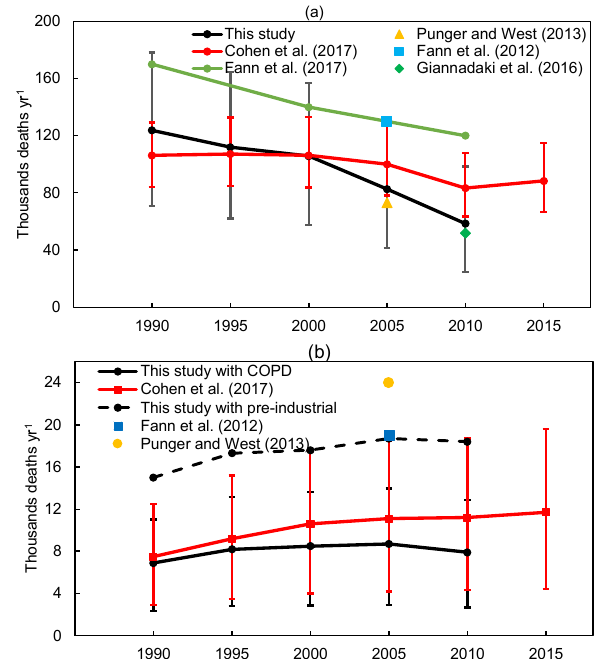
Figure 7. Comparisons of the US mortality burdens attributed to PM 2 . 5 (a) and O 3 (b) in this study, with Cohen et al. (2017), Fann et al. (2012a, 2017), Punger and West (2013), and Giannadaki et al. (2016). The black line for O 3 is the recalculated O 3 mortality burden from the COPD, and the black dashed line is the recalcu- lated O 3 mortality burden from RESP using the pre-industrial O 3 concentration as the counterfactual risk exposure factor. The error bars show the 95% CI from the RRs, shown for this study and Co- hen et al.